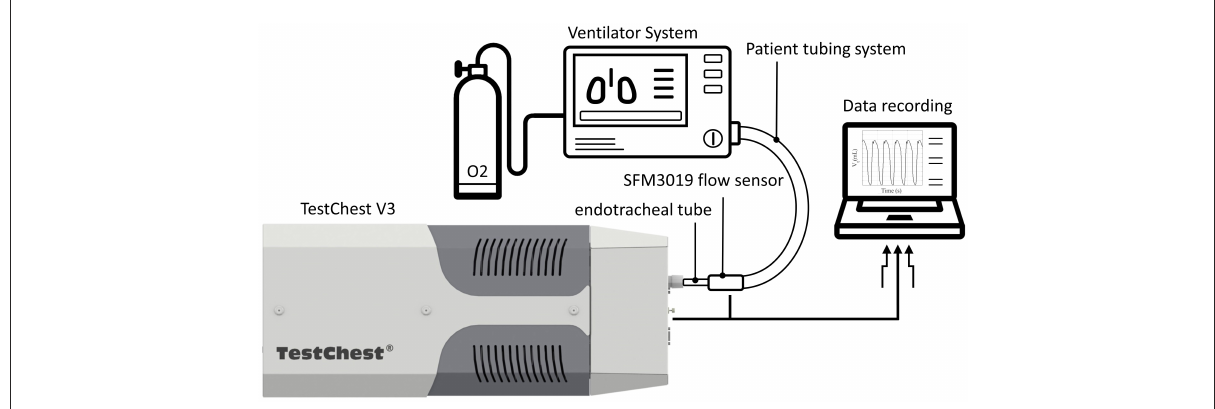
FIGURE1 Schematic overview of the test environment for the experiments. Each ventilator system was attached via a tubing system and an endotracheal tube to the TestChest. The TestChest includes a pressure and an O 2 sensor. In addition, a flow sensor SFM3019 was attached to the inlet of the TestChest to measure the actual tidal volume. A medical-grade O 2 bottle (four bar) was used for the test of the O 2